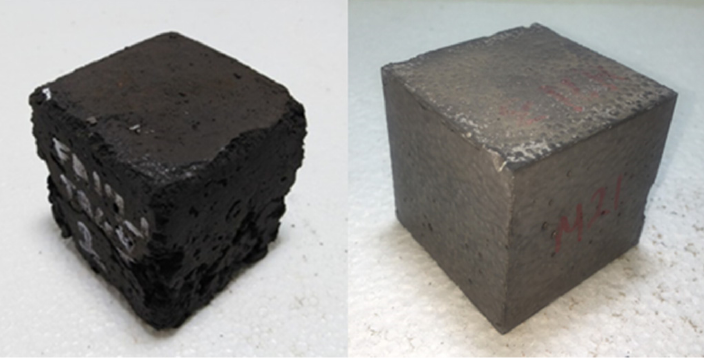
Figure 14. Reference (left) and reinforced (right) specimen after the end of freeze–thaw cycles.